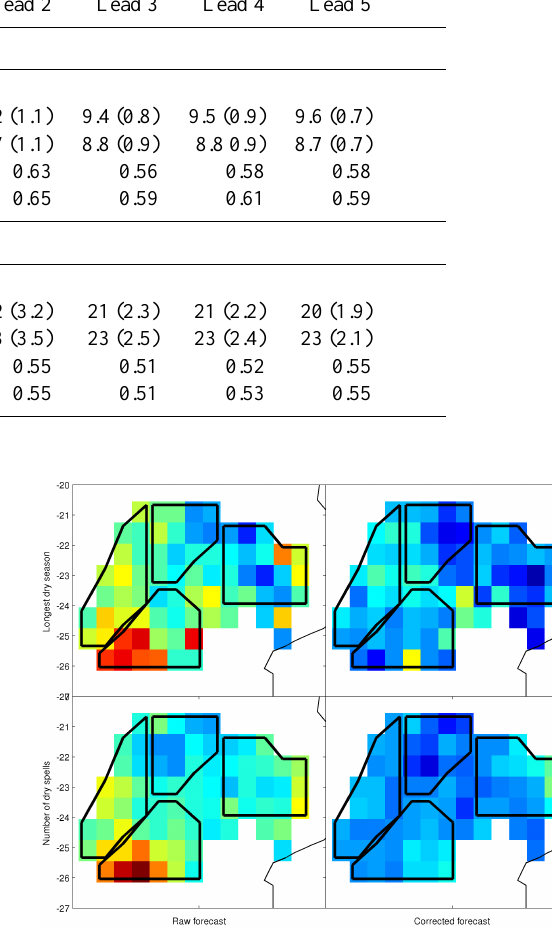
Figure 8. CRPSS for the different areas over the Limpopo basin with a precipitation threshold of 5 mm and lead time of 1